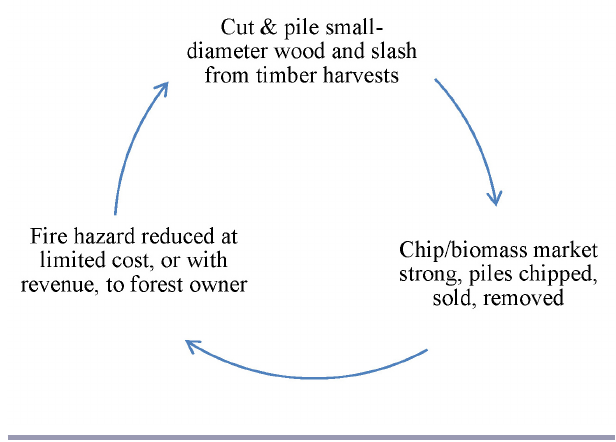
Fig. 10. Negative feedback loop in which wildfire